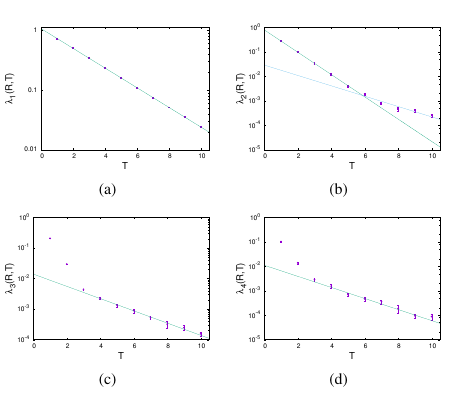
( R , T ) vs. T at R = 4 . 243 in a chiral Figure 5. λ n ( R , T ) = T nn gauge theory at finite lattice spacing with Smit-Swift regulariza- tion.